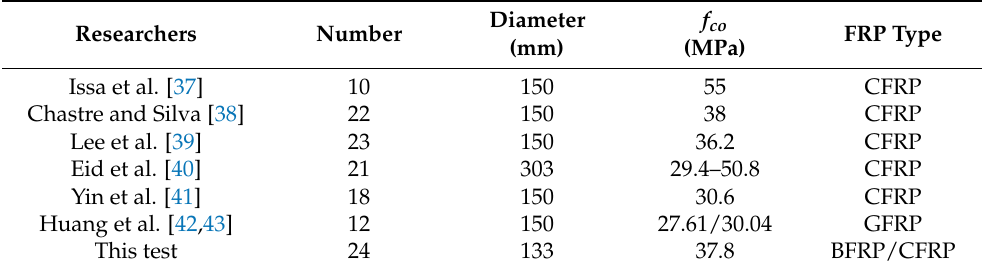
Table 4. Summary of the